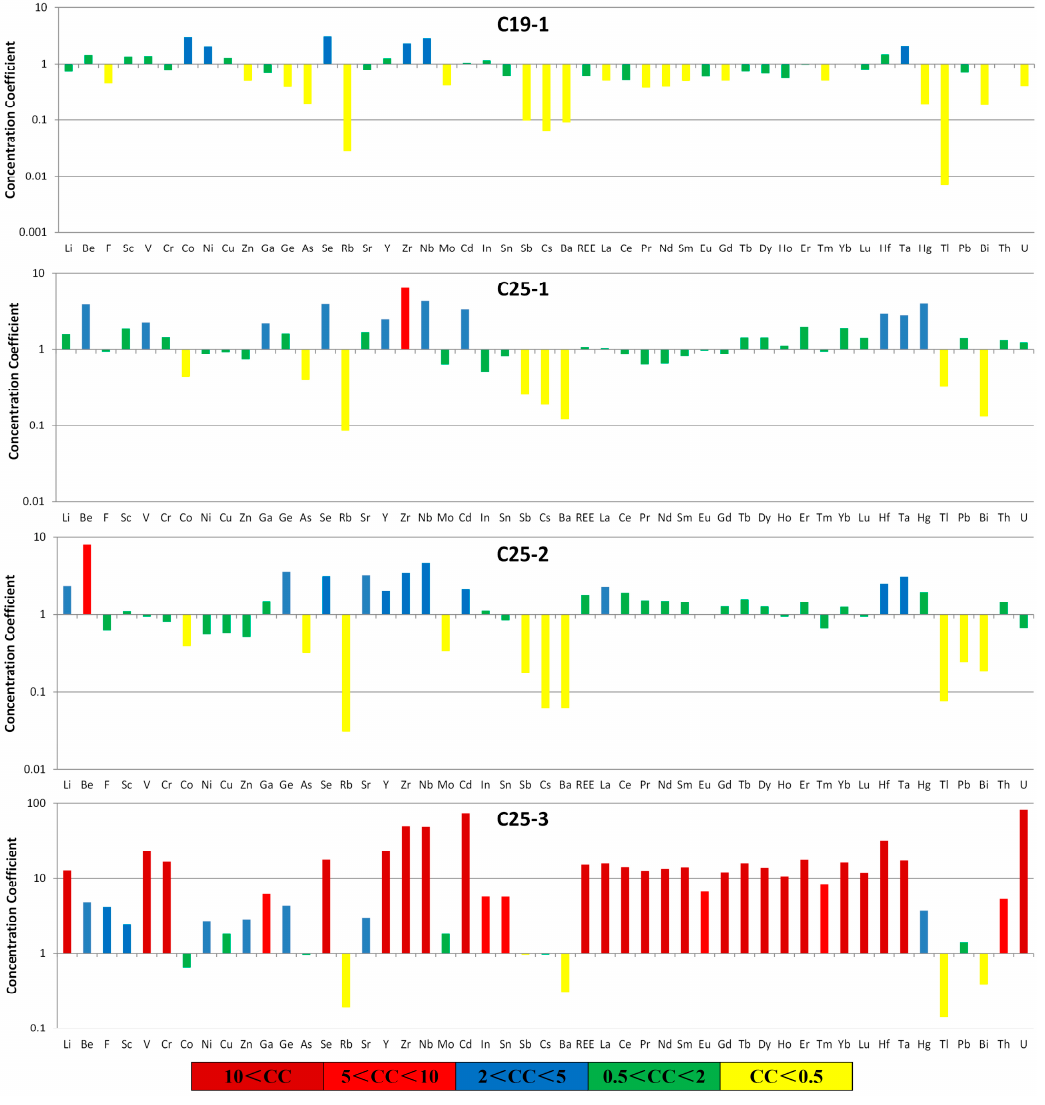
Figure 12. Concentration coefficients (CCs) of trace elements in the Shiping coals, normalized by average trace element concentrations in hard coals of the world [28] and based on the trace-element enrichment classification [29].